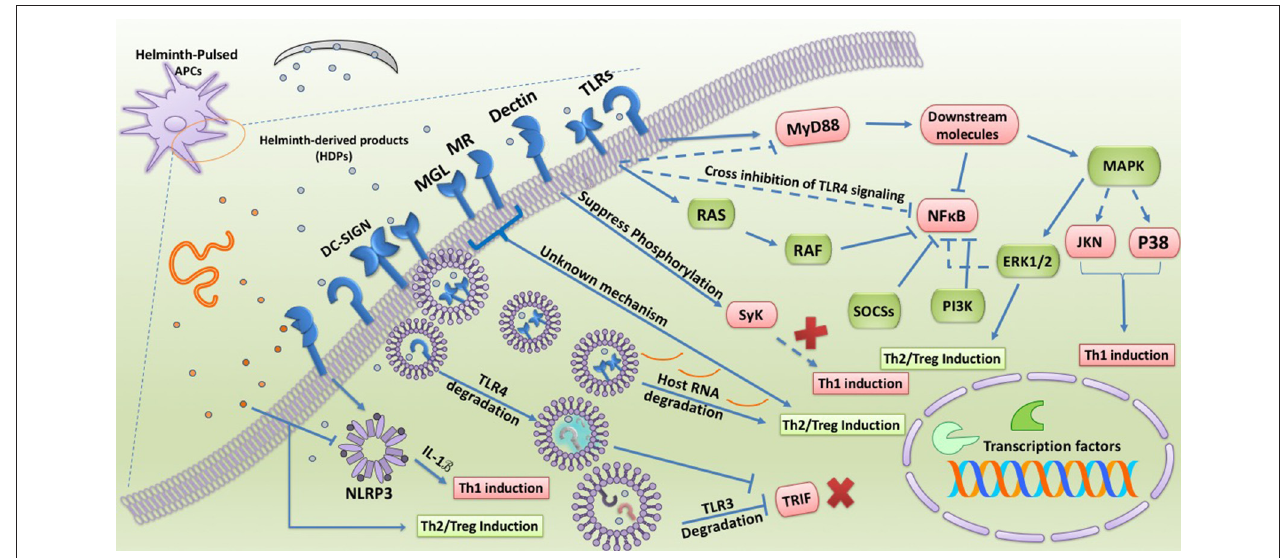
FIGURE 1 | Involvement of TLRs and CLRs during interaction with HDPs. TLRs and CLRs are widely targeted by HDPs during induction of immunomodulation and hyporesponsiveness in APCs. HDPs not only alter the expression of TLRs and CLRs in APCs but also masterfully manipulate their intracellular signaling. Some HDPs are able to redirect TLR4 signaling toward MAPK pathway and ERK1/2 activation supporting Treg/Th2 induction. In addition, co-engagement of DC-SIGN along with TLR4 enables HDPs to trigger unknown intracellular pathways which cross-inhibit MyD88 and NF κ B activation. HDPs can further restrain NF κ B activity via DC-SIGN-mediated RAF signaling along with upregulation of negative regulators of TLRs signaling, such as SOCSs and PI3K. Obviously, strict inhibition of NF κ B as the main transcription factor supporting inflammation results in prevention of priming Th1 cells. Other CLRs have been reported to participate in priming Treg/Th2 cells upon stimulation by HDPs. For example, some HDPs suppress phosphorylation of Dectin1/2-induced Syk molecule and through which inhibit deviation of immune response toward Th1. On the other hand, MR and MGL upon activation by HDPs through an unknown mechanism support Treg/Th2 differentiation. Degrading host key intracellular molecules is another strategy that HDPs exploit to reprogram host immunity. Omega-1, ES-62, and FheCL1 by degrading host mRNA, endosomal TLR4, and TLR3, respectively, not only strengthen Treg/Th2 responses but also forestall anti-parasite immunity. NLRP3 also has been revealed to be targeted by some HDPs to modulate inflammatory responses. However, there has been reported that some HDPs are able to fight anti-worm immunity by stimulation of NLRP3 leading to release of IL-1B and Th1